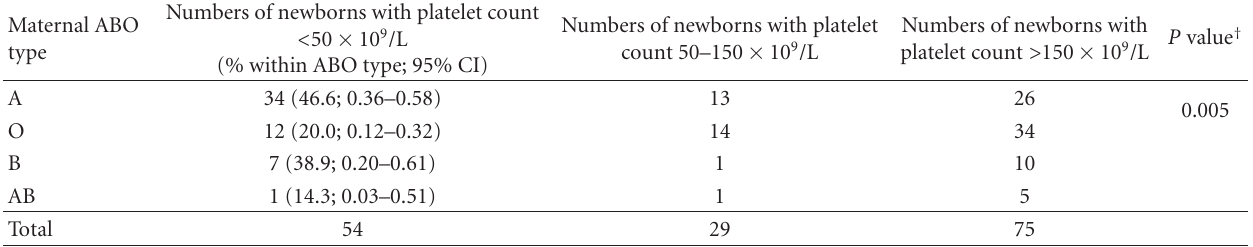
Table 1: The maternal ABO type distribution in the pregnancies compared to the severity of NAIT. Maternal ABO